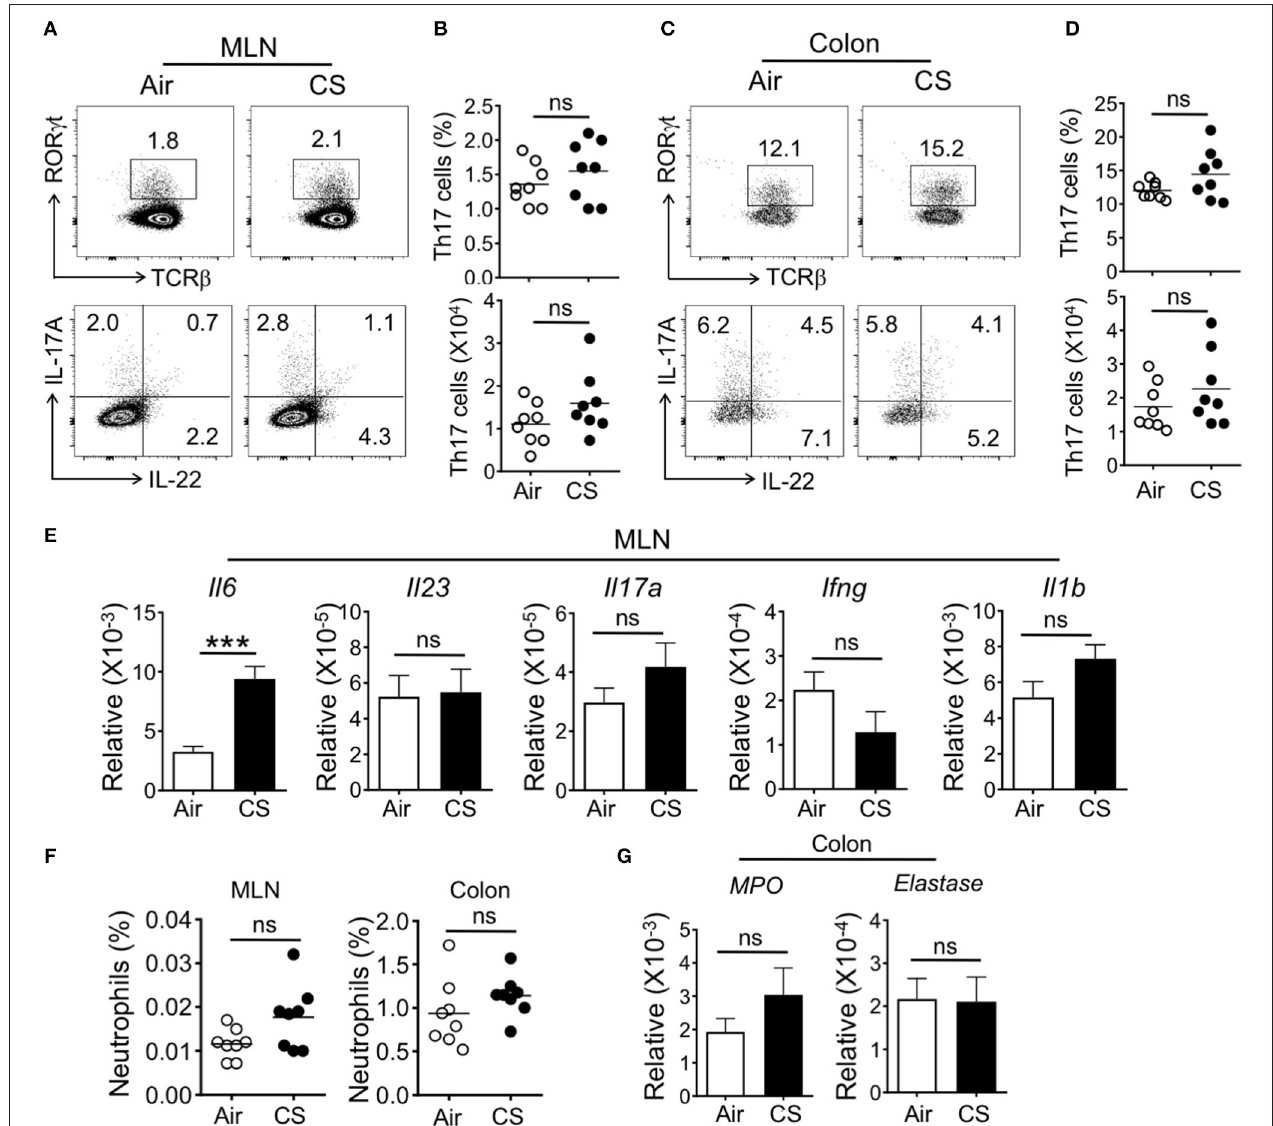
FIGURE 3 | CS exposure alone does not enhance intestinal Th17 cell and neutrophil responses. Mice were exposed to air or CS for 2 months. (A–D) Frequencies (%) and absolute numbers of Th17 cells (gated on CD3 + CD4 + ) in mesenteric lymph node (MLN) and colonic lamina propria as determined by flow cytometry. (A,C) Representative dot plots are shown of total Th17 cells (CD3 + CD4 + TCR β + ROR γ t + cells, top) and IL-17A expressing Th17 cells (CD3 + CD4 + IL-17A + cells, bottom). (B,D) Frequency and absolute cell numbers of IL-17A producing cells (CD3 + CD4 + IL-17A + cells). (E) mRNA expression as determined by qRT-PCR for cytokines in MLN from Air and CS mice. (F) Frequencies of neutrophils (CD11b + Ly6G + cells) in MLN and colon. Percentages of CD11b + Ly6G + neutrophils among live cells are shown. (G) mRNA expression as assessed by qRT-PCR for neutrophil response genes in the colon tissues from Air and CS mice. Data is representative of two independent experiments with eight animals per group (mean ± SEM). Student’s t -test was used to determine significance. ns, P > 0.05; *** P < 0.001.